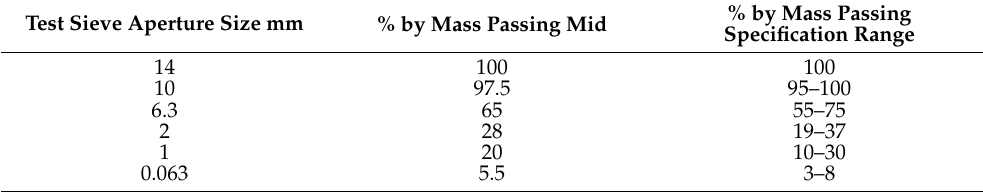
Table 1. Aggregate grading for 0/10 mm size close-graded surface course (BS EN 13108-1). Test Sieve Aperture Size mm